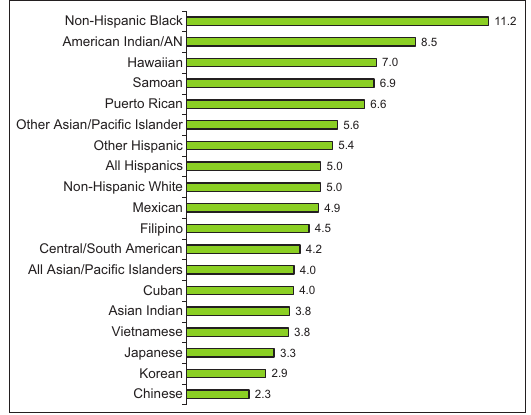
Figure 4 : Infant Mortality Rate (IMR) per 1,000 Live Births for Detailed Racial/Ethnic Groups, United States, 2014-2016 (US Total =5.9) Source: Derived from the 2014-2016 Linked Birth/Infant Death Period Files.